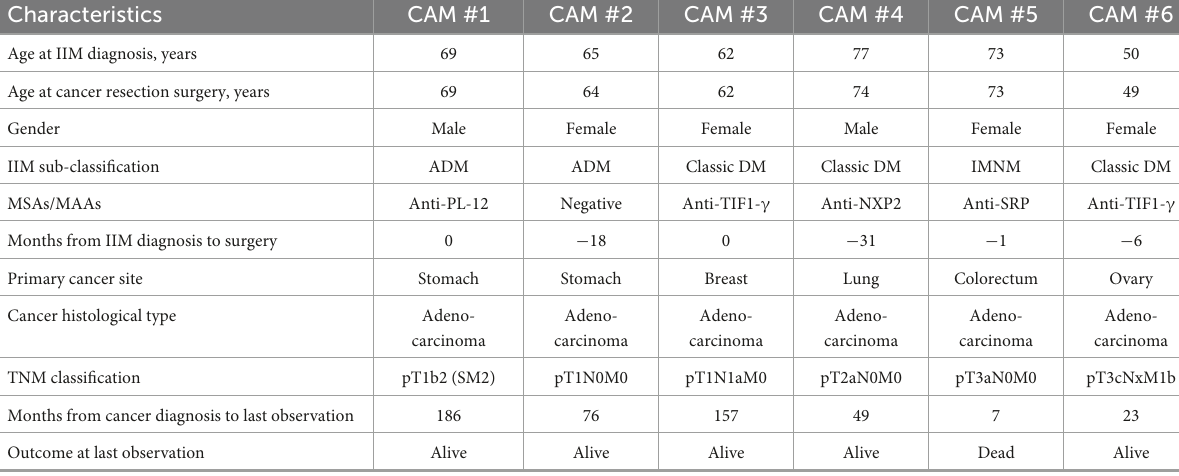
TABLE 1 Clinical characteristics of 6 patients with